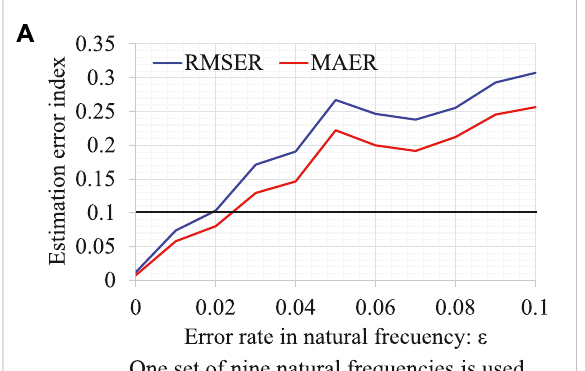
column were obtained from the design document.